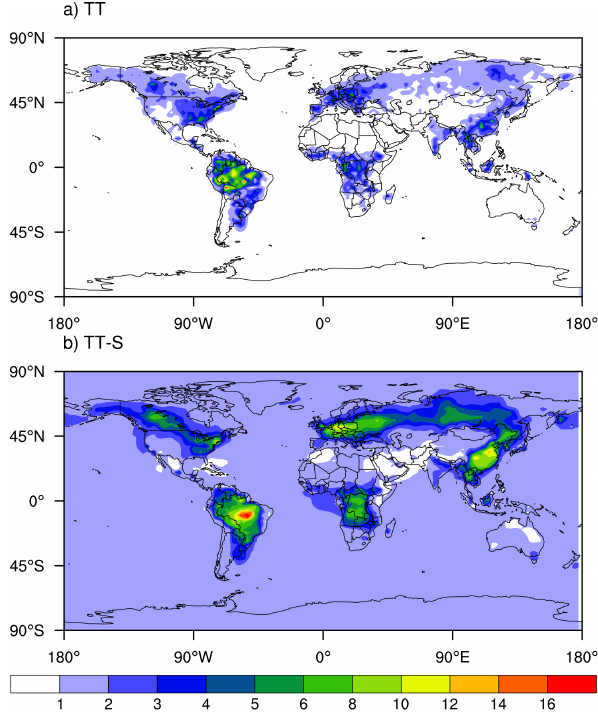
Figure 10. Root-mean-square errors (RMSEs) (units are 10 − 11 kgCm − 2 s − 1 ) for the daily (a) TT- and (b) TT-S-assimilated CO 2 surface fluxes during the period from 1 July to 31 December 2010.